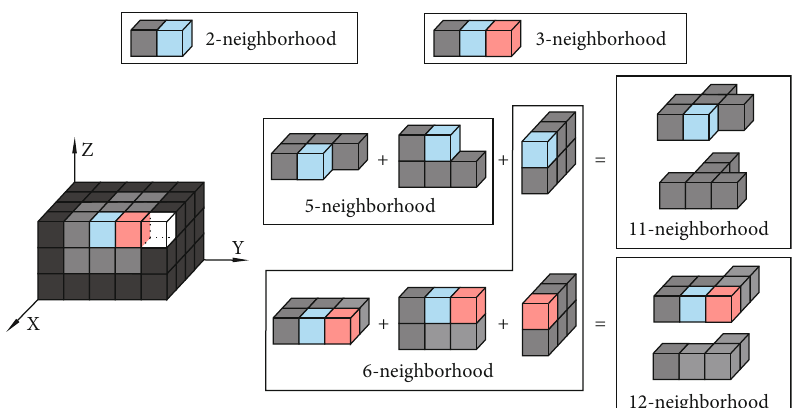
Figure 2: The n -neighborhoods contained in 15-neighborhood (synthesized from 11-neighborhood and 12-neighborhood).